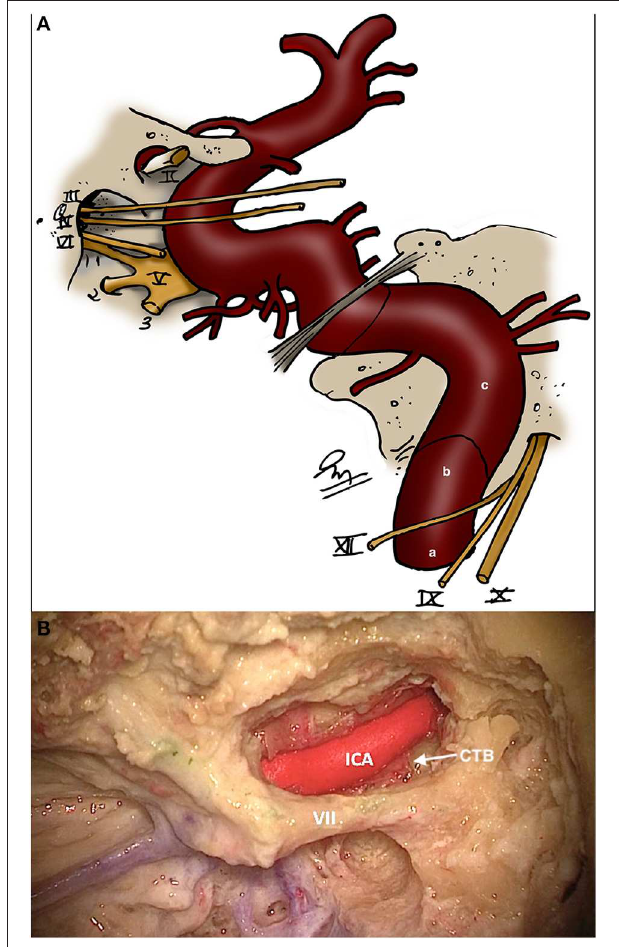
FIGURE 5 | (A) Schematic showing the three portions of the petrous segment of the internal carotid artery [Modified from Ramina and Tatagiba ( 3)]. (a) Ascending (vertical). (b) Genu. (c) Horizontal. (B) Horizontal segment of the carotid artery in the petrous bone and its relationship with the facial nerve and caroticotympanic branches (CTB). III, oculomotor nerve; IV, trochlear nerve; V, trigeminal nerve; VI, abducens nerve; VII, facial nerve; IX,